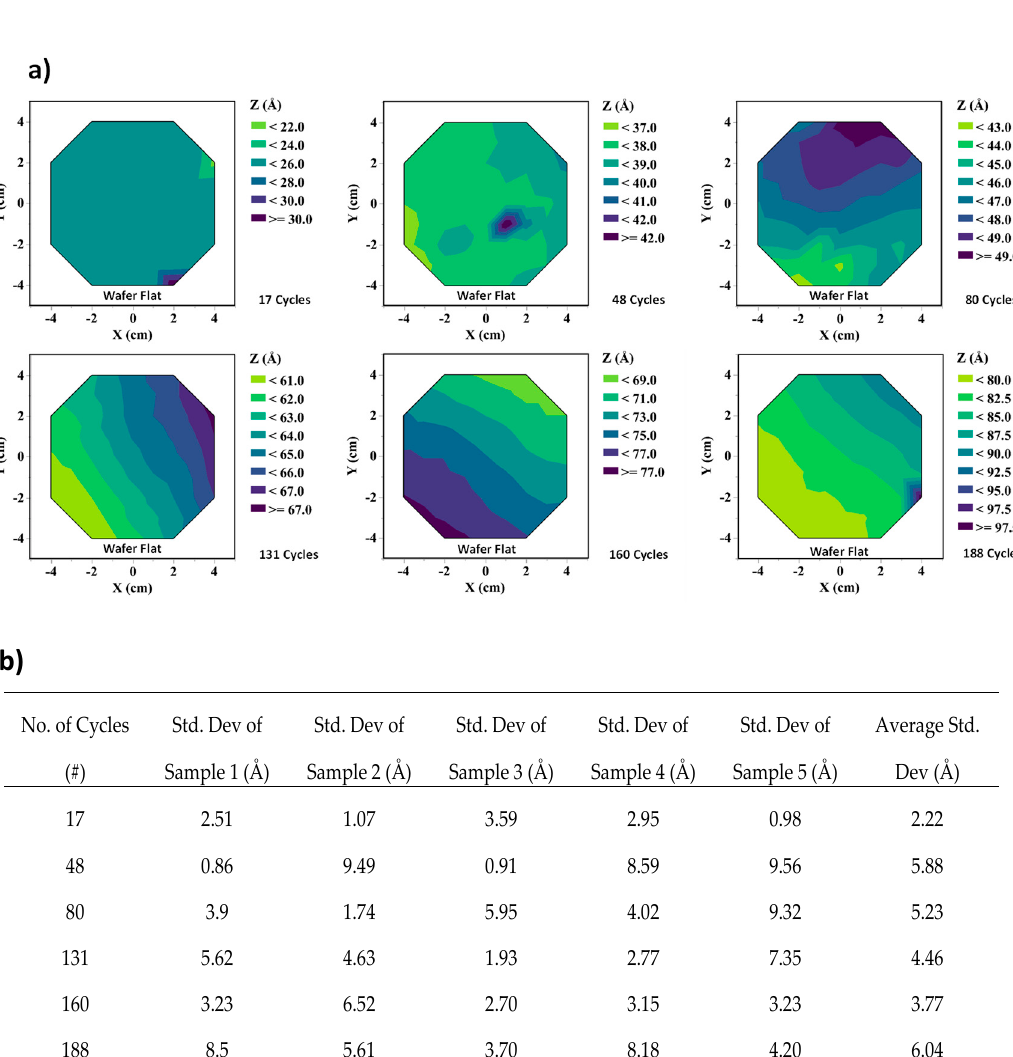
Figure 5. ( a ) Film thickness contour mapping, as measured by optical methods, on 4-inch wafers for di ff erent thicknesses of SiO 2 and ( b ) non-uniformity measurements of di ff erent SiO 2 films done on five samples for each specific thickness.